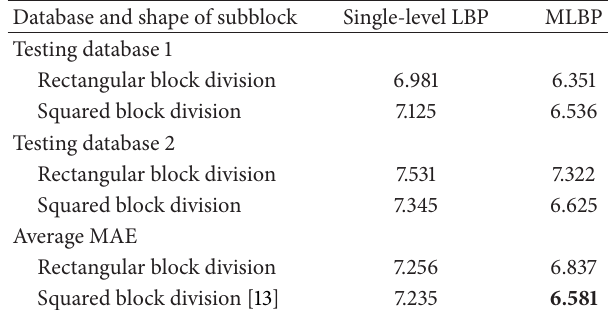
Table 1: Comparisons of MAEs of MLBP method to those of single- level LBP method (unit: years old).